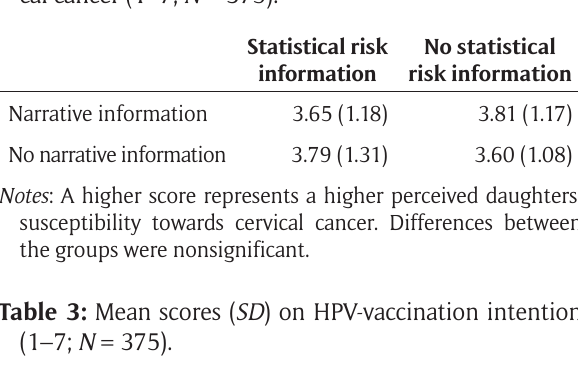
Table 2: Mean scores ( SD ) on susceptibility towards cervi- cal cancer (1–7; N = 375).